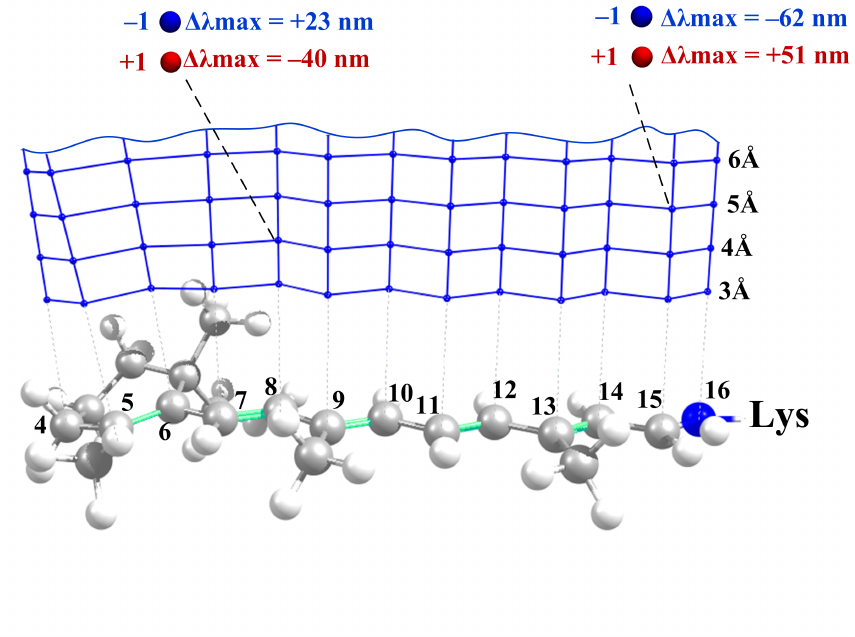
Figure 2. Grid representing the positions of a unit charge relative to the all-trans PSB. At each grid point we performed an ab initio calculation of ∆ λ max values for the positive and negative unit